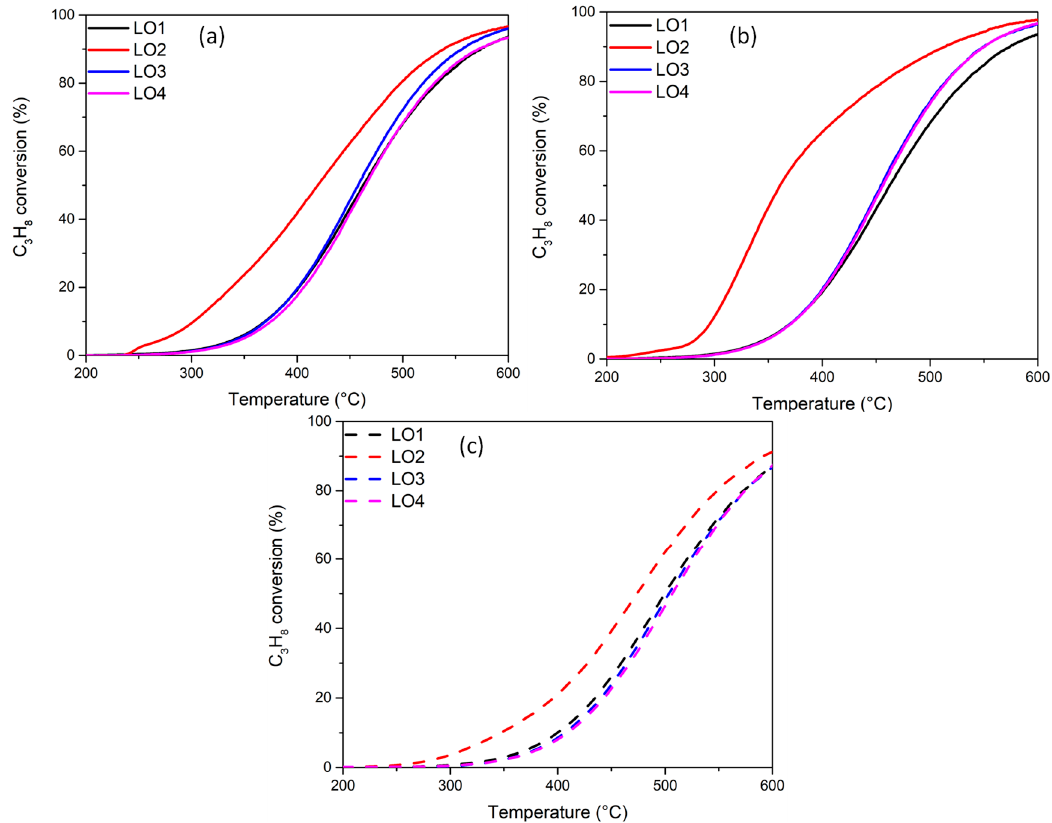
Figure 6. Variation of the propane conversion as a function of the temperature ( a ) for Pd-HS (reduction step in H 2 ), ( b ) for Pd-HS (reduction step in CO), ( c ) for Pd-LS (reduction step in H 2 ). Reaction mixture: C 3 H 8 /O 2 : 2000 ppm/9 vol%.